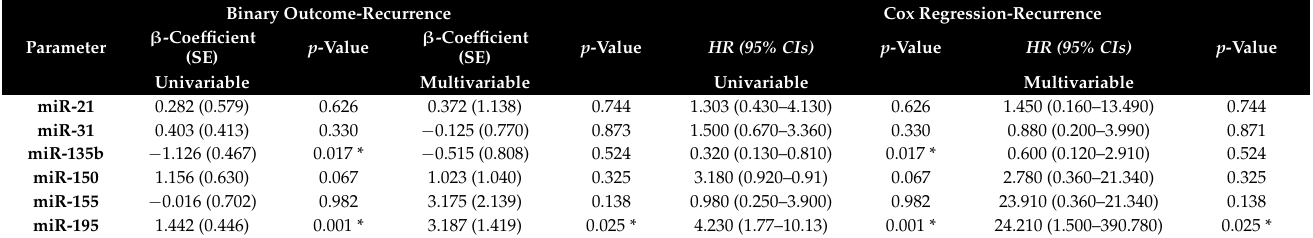
Table 4. Binary logistic and Cox regression analyses to determine predictors in modelling time to